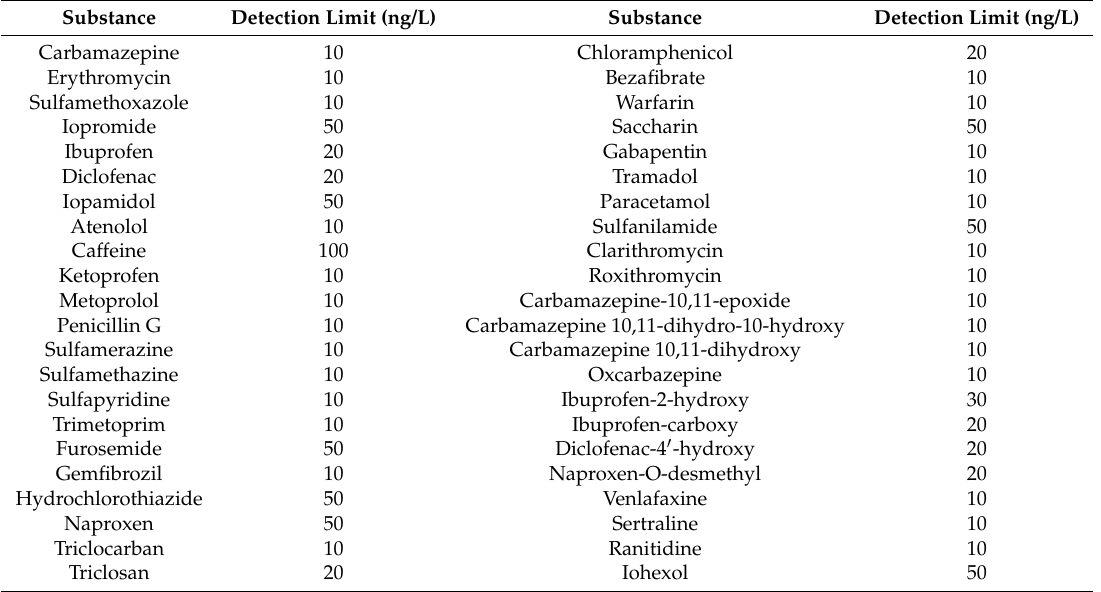
Table 4. Detection limits for analyzed